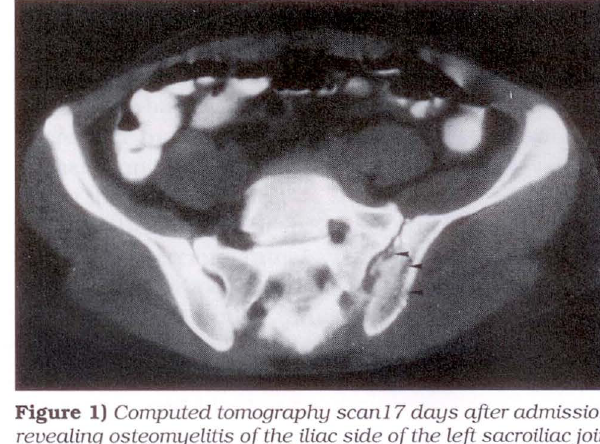
Figure 1) Computed tomography scan17 days after admission, revealing osteomyelitis of the iliac side of the left sacroiliacjoint with persistance of musculature enlargement